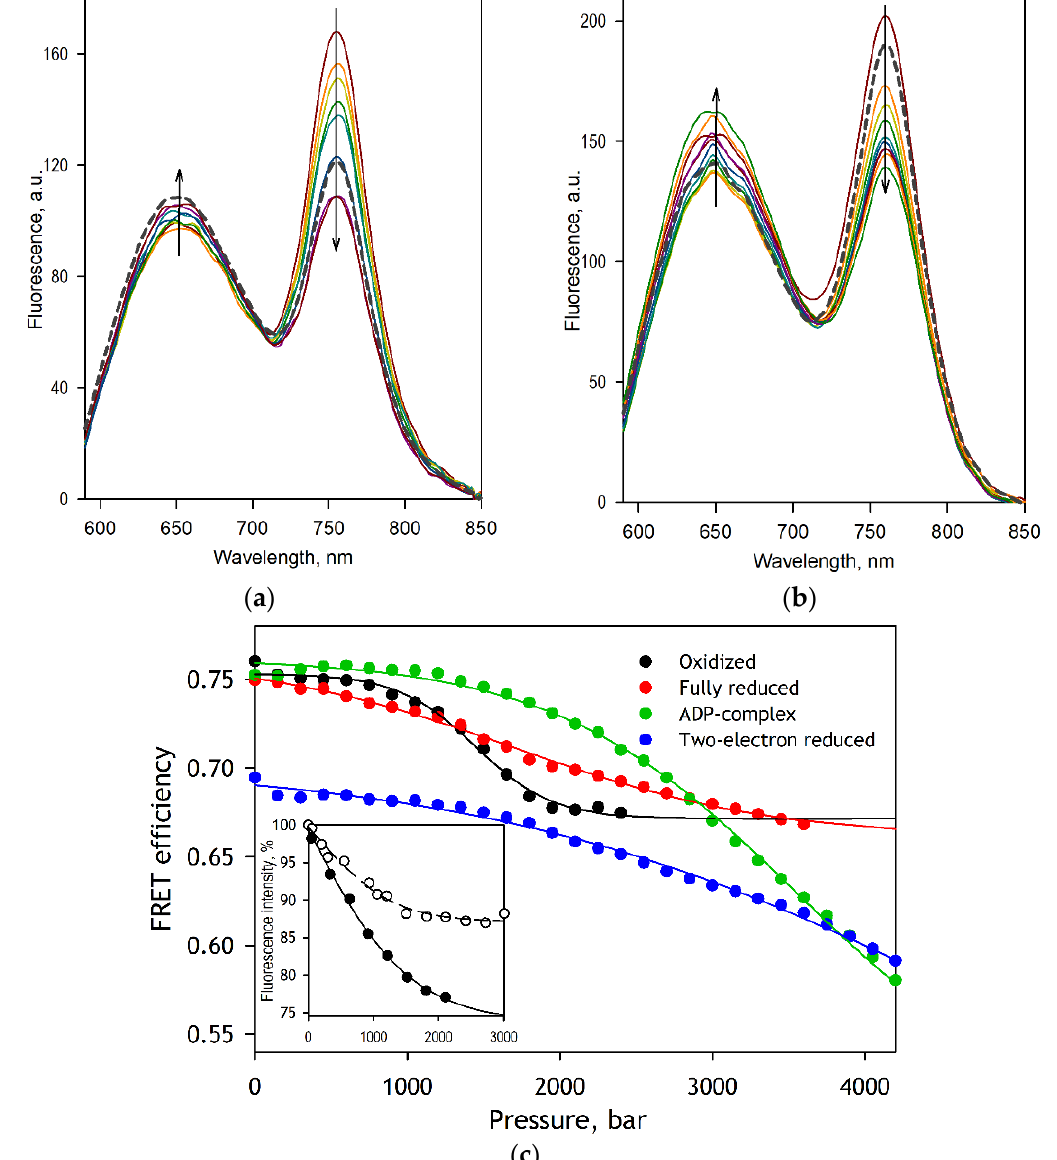
Figure 5. Pressure-induced changes in the spectra of fluorescence of SbCPR-2DY. Panels ( a , b ) show the series of spectra recorded at increasing pressure with the oxidized ( a ) and reduced ( b ) enzyme. The spectra shown in solid lines were recorded at 1, 300, 600, 900, 1200, 1500, 1800, 2100, and 2400 bar. In the case of the reduced enzyme, this set is complemented with the spectra recorded at 3000, 3600, and 4200 bar. The spectra shown in thick gray dashed lines were recorded after decompression to the ambient pressure. The pressure dependencies of FRET efficiency obtained with four different enzyme states are exemplified in the main plot of the panel ( c ). Here, the solid lines show the approximations of the datasets with Equation (6). The inset in this panel exemplifies the pressure dependencies of the relative fluorescence intensity of the double-labeled enzyme with excitation at 617 nm (filled circles, solid line) and single-labeled SbCPR-DY520XL with excitation at 505 nm (open circles, dashed line). Lines show the approximations of the datasets with Equation (6).